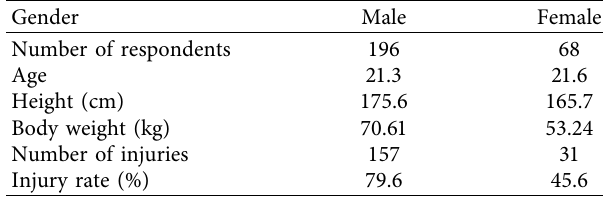
Table 1: Basic information of survey respondents.